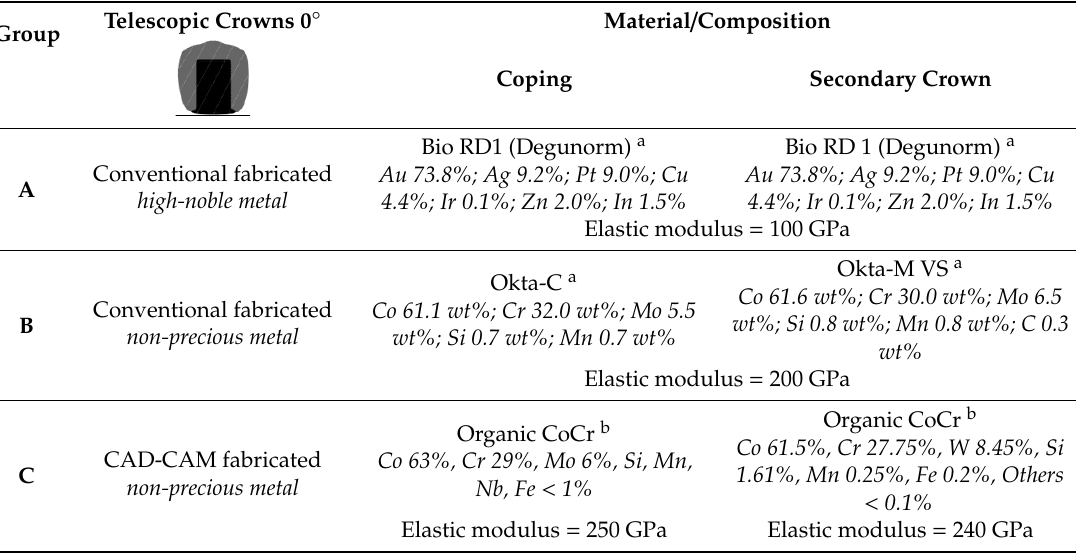
Table 1. Telescopic crowns and components used according to the manufacturer´s specifications.